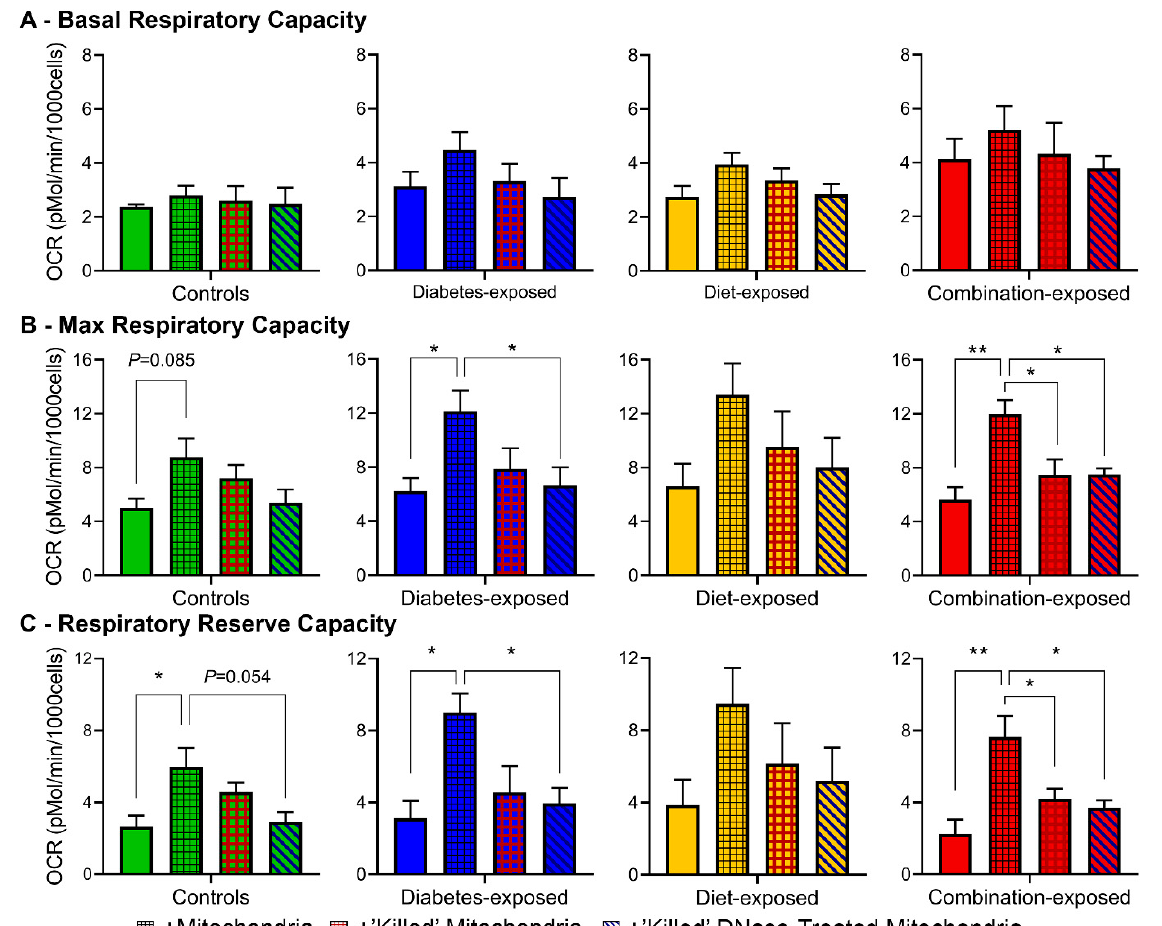
Figure 7. MtDNA plays a role in respiratory boost of mitochondrial transfer. ( A ) Basal, ( B ) FCCP-stimulated maximal, and ( C ) reserve respiratory capacities of CM treated with sham (solid), living–respiring (black hashing), “killed” (red hashing), and “killed”+DNase-treated mitochondria (diagonal). N = 4–6 per group. Data represent mean ± SEM. P ≤ 0.05: # mitochondrial effect by 1-way ANOVA. ** P <